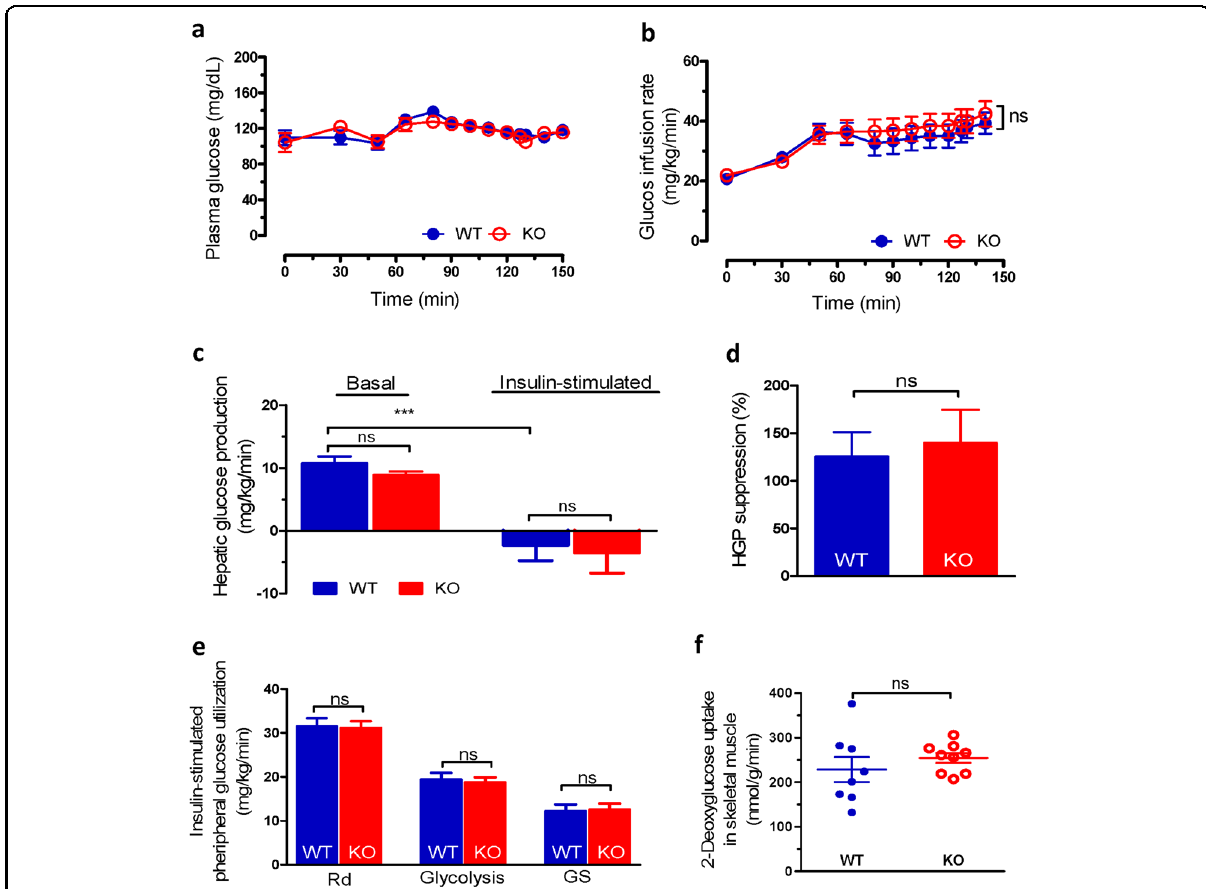
Fig. 2 Fbp2 deletion did not alter glucose metabolism during feeding-mimicking conditions. a Plasma glucose level, b glucose infusion rate during hyperinsulinemic-euglycemic clamp, c basal and clamped glucose level, d percentage of suppression of hepatic glucose output, and e clamped glucose uptake, glycolysis rate, and glycogen synthesis rate calculated using the hyperinsulinemic-euglycemic clamp results. n = 9 per group. f Muscle 2-DOG uptake results. n = 8 – 9 per group. HGP hepatic glucose production, Rd glucose disposal rate, GS glycogen synthesis rate. Data are expressed as the mean ± SEM and were analyzed by two-way ANOVA with post hoc analysis for a and b and by Student ’ s t -test for c – g . ** P < 0.01, *** P < 0.001, ns nonsigni fi